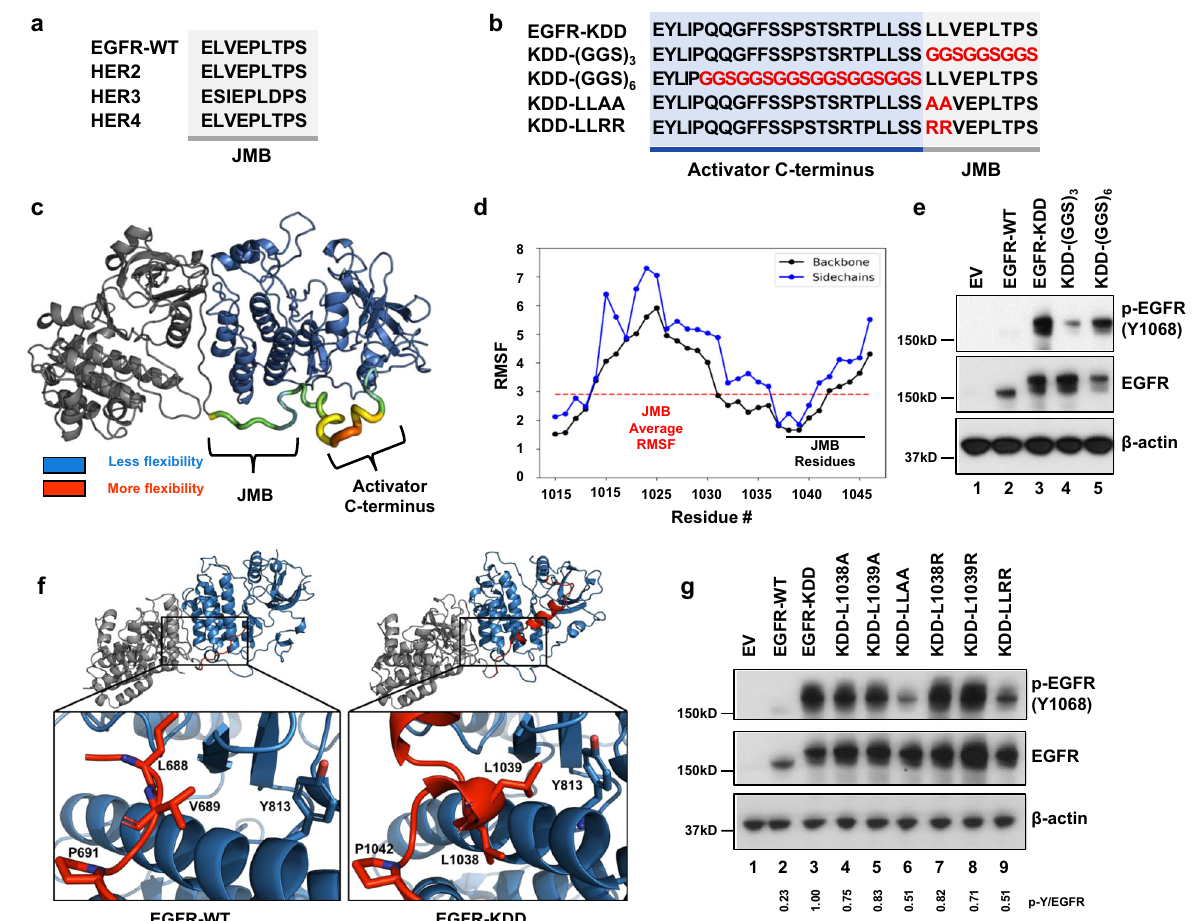
Fig. 2 The EGFR-KDD linker has distinct enthalpic and entropic contributions to intra-molecular dimer formation. a Amino acid sequence alignment of EGFR-WT, HER2, HER3, and HER4 JMB domain. b Amino acid sequence alignment of EGFR-KDD mutants to evaluate linker contributions. Residues in the activator C-terminus kinase domain (TKD1) highlighted in blue (white font). Residues in the receiver JMB domain highlighted in gray (black font). Mutations indicated by red font. c Per-residue root-mean-square- fl uctuation (RMSF) of the EGFR-KDD linker region following an additional 1 µ s of MD simulation (post-Rosetta modeling and initial 1 µ s MD simulation). RMSF values are mapped onto the structure to indicate regional fl exibility. Color gradient and cartoon structure width indicate fl exibility. Less fl exible = smaller width, colored blue; more fl exible = larger with, colored red. d Graphical representation of per-residue RMSF displays linker residue # on x -axis and RMSF on y -axis; black horizontal line indicates JMB residues, red dashed horizontal line indicates average RMSF of JMB residues. e HEK293 cells transiently transfected with EGFR-KDD or (GGS) n mutants. After 48 h transfection, cells were collected for western blot analysis. EV empty vector. f Detailed structural models of the EGFR-WT homodimer with the JMB domain, and the EGFR-KDD intra-molecular dimer, were generated with Rosetta and re fi ned with 1 µ s MD simulations. g HEK293 cells transiently transfected with EGFR- KDD and different JMB interface mutants. After 48 h transfection, cells were collected for western blot analysis. p-Y/EGFR, the ratio of phosphotyrosine content at Y1068 to total EGFR expression for each construct relative to EGFR-KDD was shown. EV empty vector. For e and g , n = 3 experiments were repeated independently with similar results. Results are the representative of three independent experiments. Source data are provided as a Source Data fi le. For c and f , the model coordinates are provided in Supplementary Data 1 –